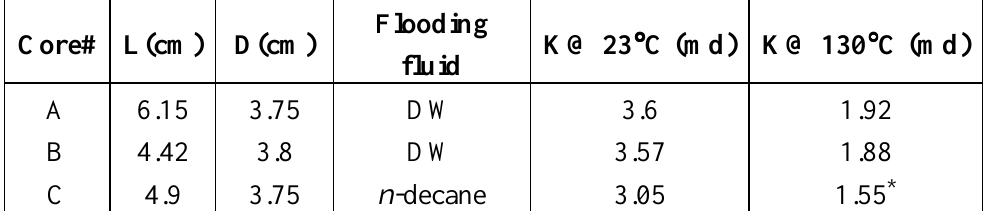
Table 5. Core data and the estimated absolute permeability at 23 and 130 (cid:176)